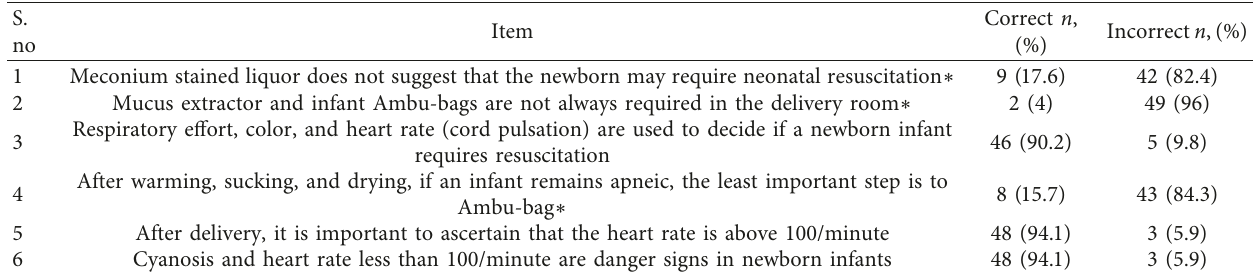
Table 1: Pre-intervention knowledge of evaluation in neonatal resuscitation of undergraduate final-year anesthesia students at a com- prehensive specialized teaching referral hospital in Ethiopia, ( N � 51).